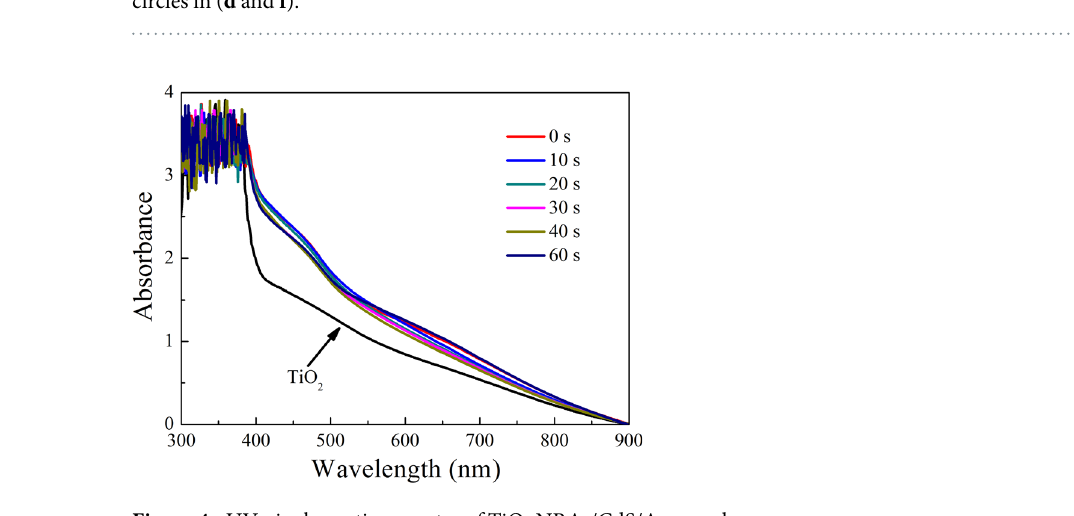
Figure 4. UV-vis absorption spectra of TiO 2 NRAs/CdS/Au